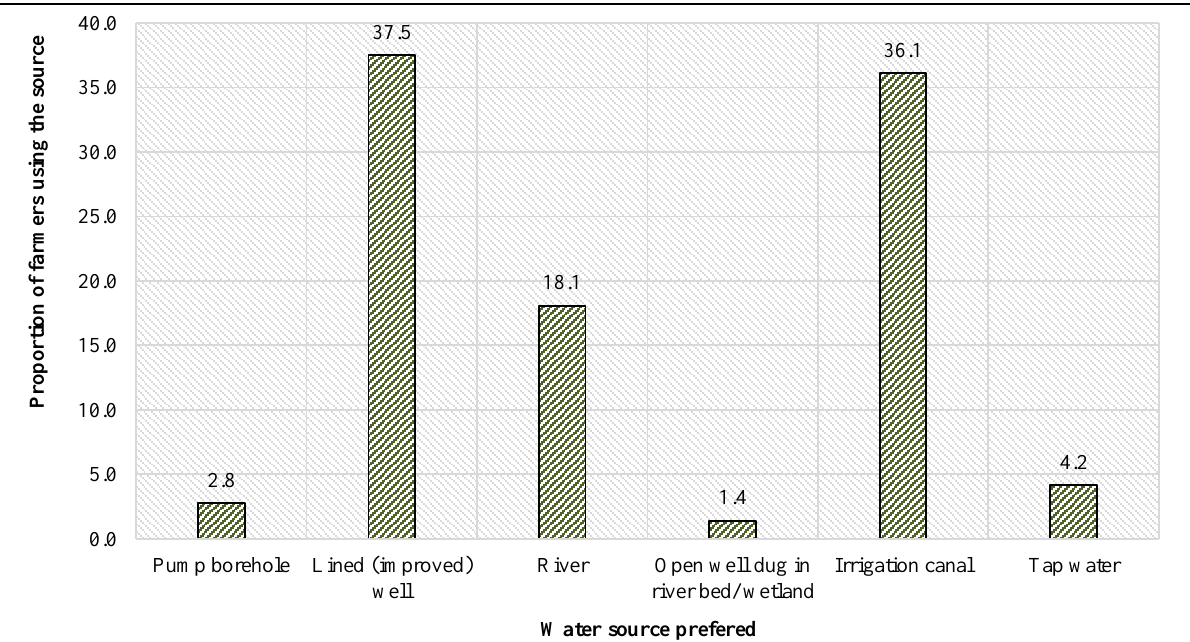
Figure 5. Preference of different water source at the community